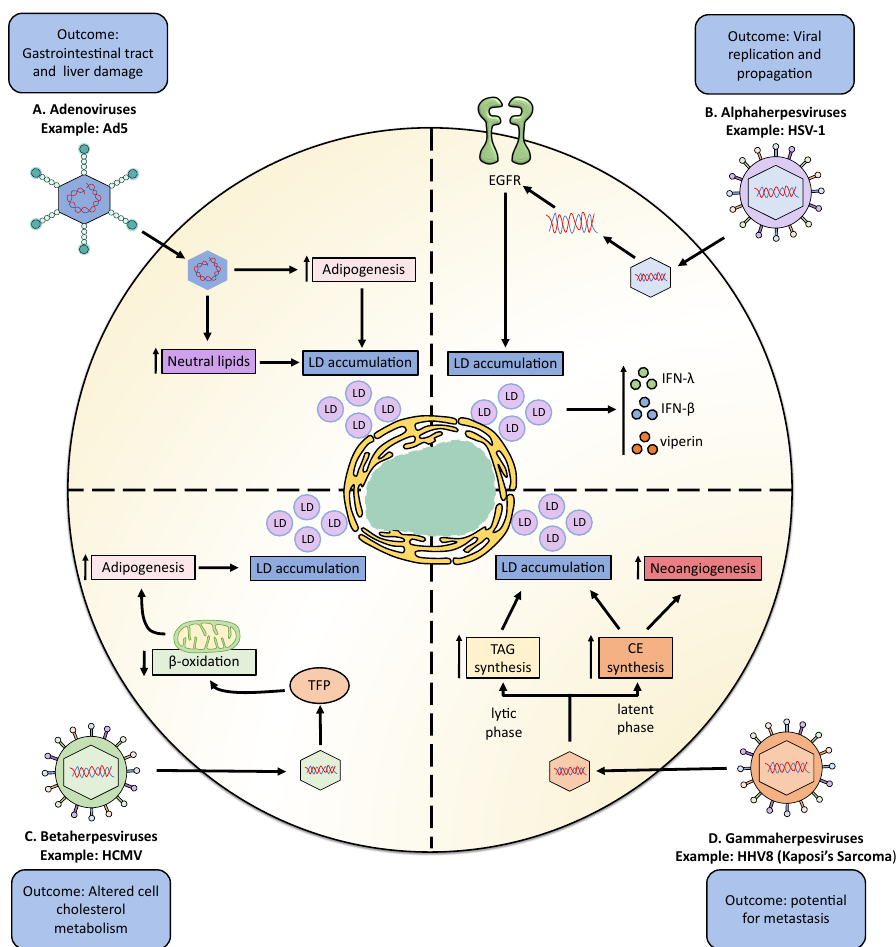
Figure 2. Summary of interactions between selected clinically relevant DNA viruses and LDs leading to pathophysiological outcomes. ( A ) Interactions between Adenovirus 5, an adenovirus, and LDs biogenesis. ( B ) Interactions between herpes simplex virus type 1 (HSV-1), an alphaherpesvirus, and host LDs. ( C ) Interactions between LDs and the human cytomegalovirus (HCMV), a betaher- pesvirus. ( D ) Interactions between neutral lipid metabolism and human herpes virus 8 (HHV8), a